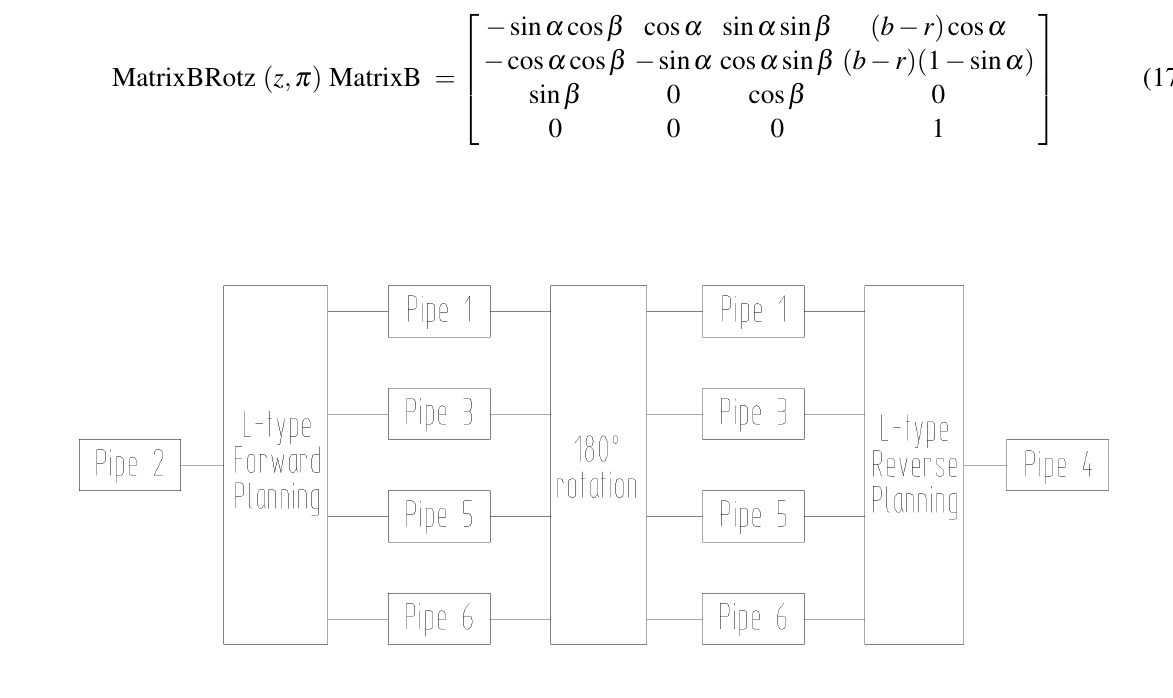
Fig. 15 The planning principle over the obstacle on the coaxial pipeline of space